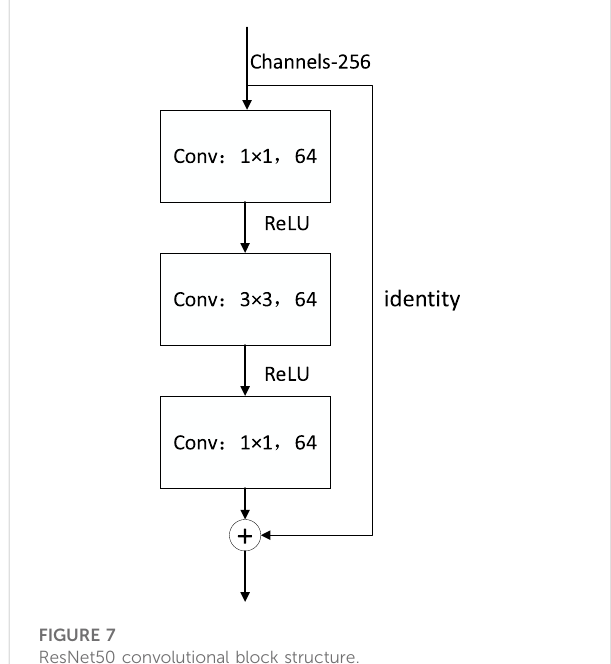
FIGURE 7 ResNet50 convolutional block structure.